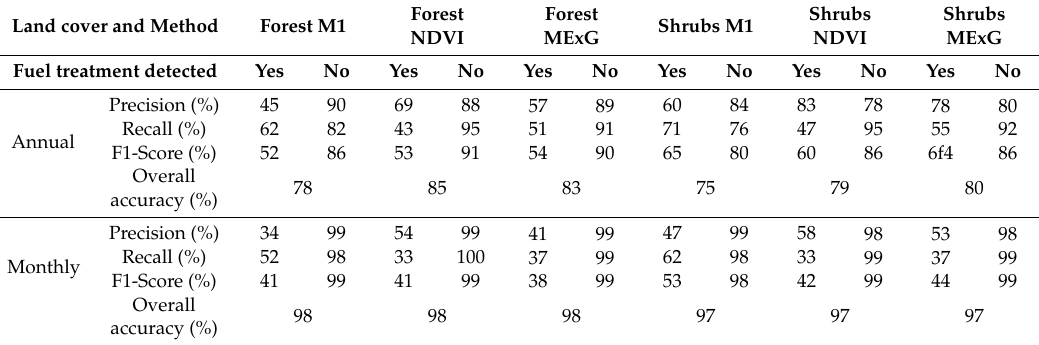
Table 5. Comparison of the accuracies obtained for two land cover types: Forest and Shrubs; for the pair MaxEnt-NDVI from Method 1 (M1) and the indices NDVI and MExG from Method 2 with α = 0.0005, at annual and monthly